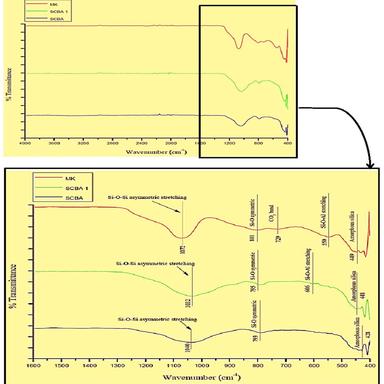
FTIR image of SCBA and MK samples.